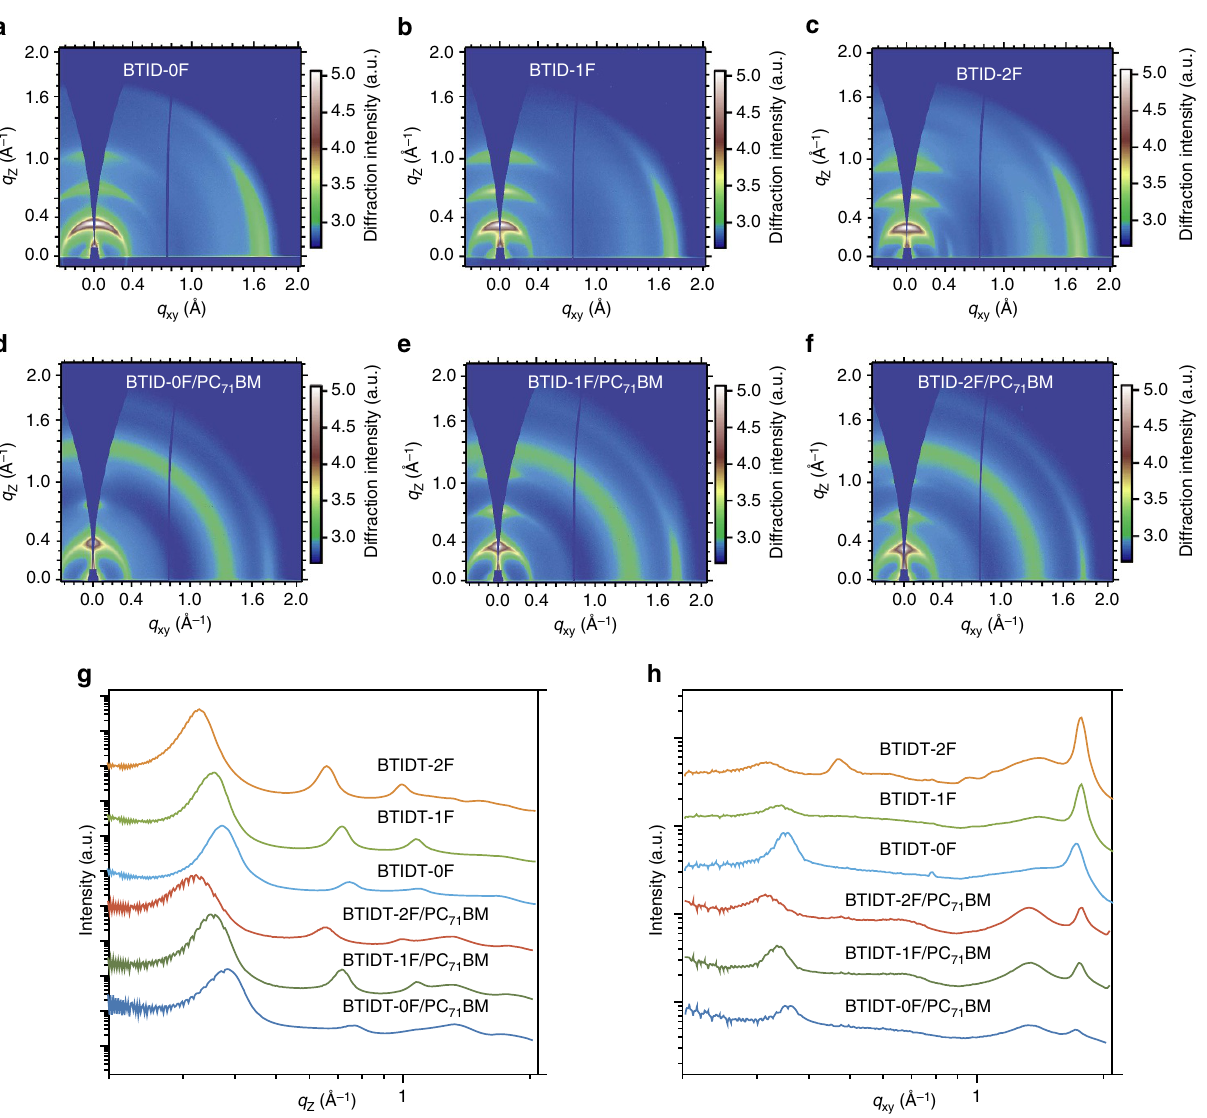
Figure 3 | Microstructures of pristine and blend films. ( a – f ) GIWAXS images in pristine films on Si substrate and GIWAXS images in blends films on ZnO/Si substrates; ( g ) corresponding out-of-plane curves; and ( h ) corresponding in-plane